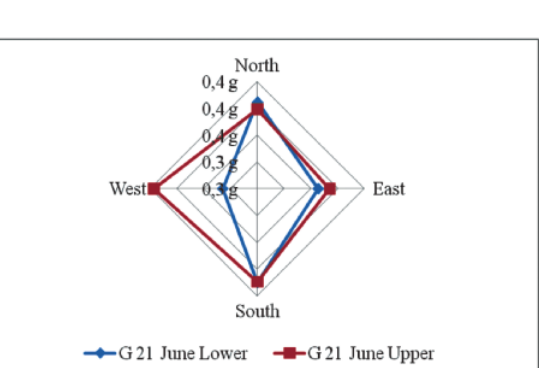
Fig. 10: Stone mass in the function of orientation and height in the case of